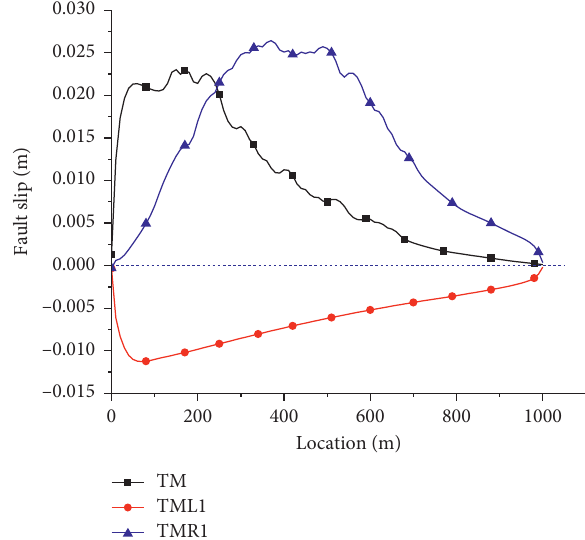
Figure 5: Fault slip along the fault plane when the fracturing region was TM, or TML1, or